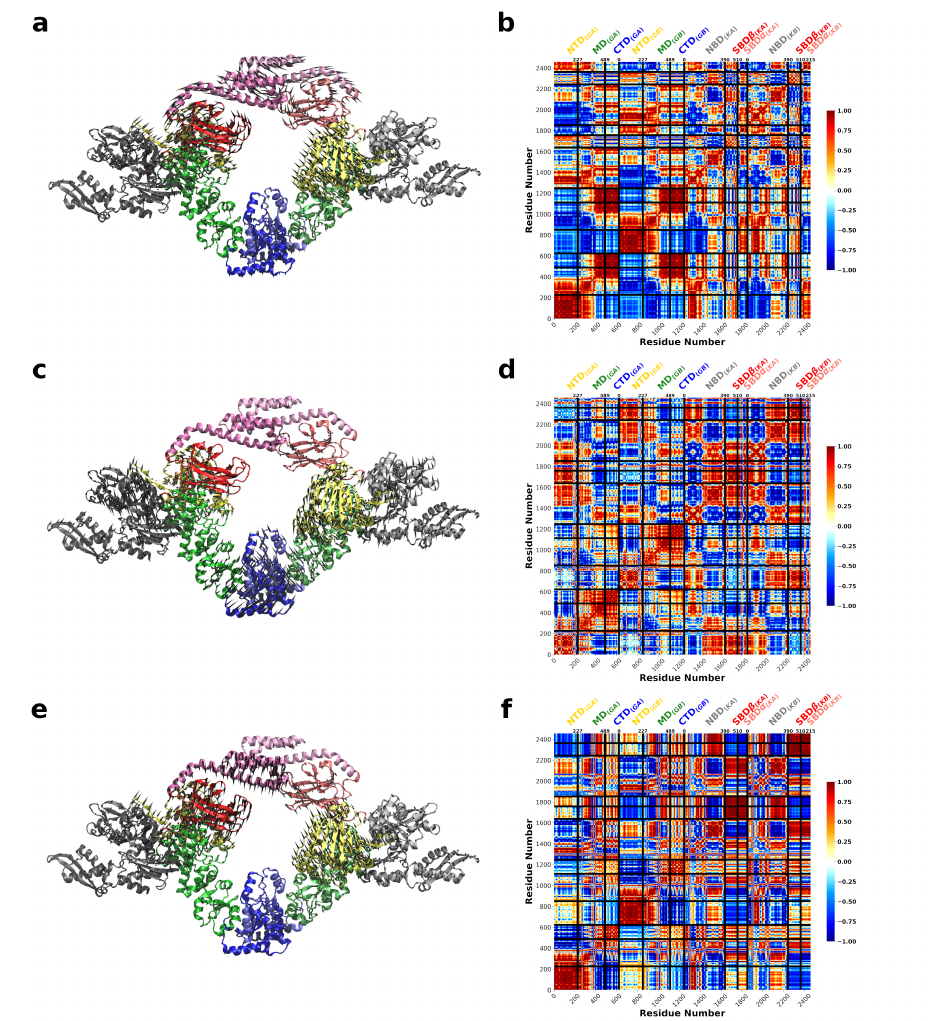
Figure 7. Motions associated with significant normal modes of one Hsp90 Ec dimer when two DnaK monomers are bound. ( a ) Mode 13 is characterized by a torsional motion about the C-terminus of Hsp90 Ec . The DnaK SBDs are oriented toward the client binding region of Hsp90 Ec resulting in steric clashes. ( b ) The covariance matrix of amino acid pairs for Mode 13. ( c ) Mode 28 involves a torsional motion of Hsp90 Ec about the CTD dimerization domain. The NBD of both DnaK molecules moves away from the axis of Hsp90 Ec while the DnaK SBDs are immobile. ( d ) The covariance matrix of amino acid pairs for Mode 28. ( e ) Mode 8 also involves a torsional motion about the Hsp90 Ec CTD similar to Mode 13, but with the SBDs of each DnaK moving away from the Hsp90 Ec vertex. ( f ) Covariance matrix of amino acid pairs for Mode 8. Arrows in ( a , c , e ) indicate the amplitude and direction of motions of amino acids in each mode. Correlated movements in covariance matrices ( b , d , f ) are highlighted in red while anticorrelated movements are represented in